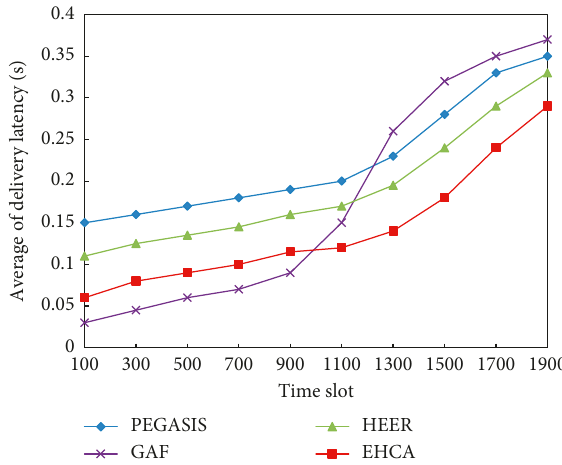
Figure 9: Average delay of data delivery to the sink.